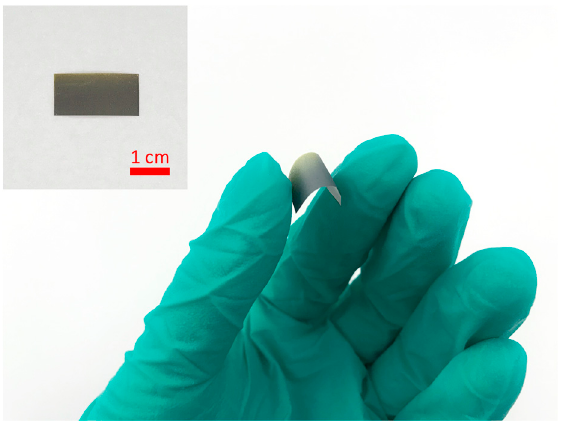
Figure 1. Spray-on graphene / polyvinylpyrrolidone (PVP) sensor on polyimide (PI) film.